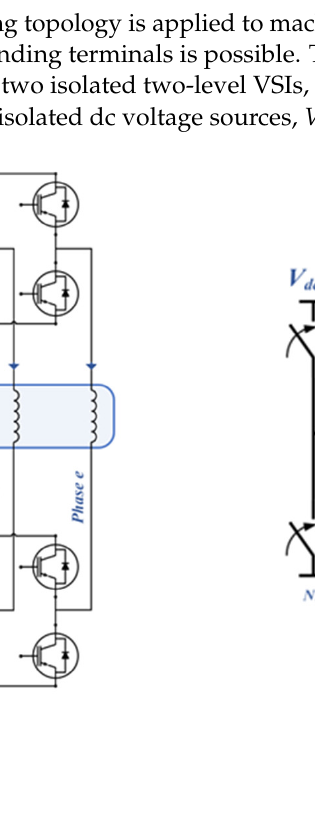
Figure 14. ( a ) Five-phase dual supply drive; ( b ) Corresponding inverter leg.